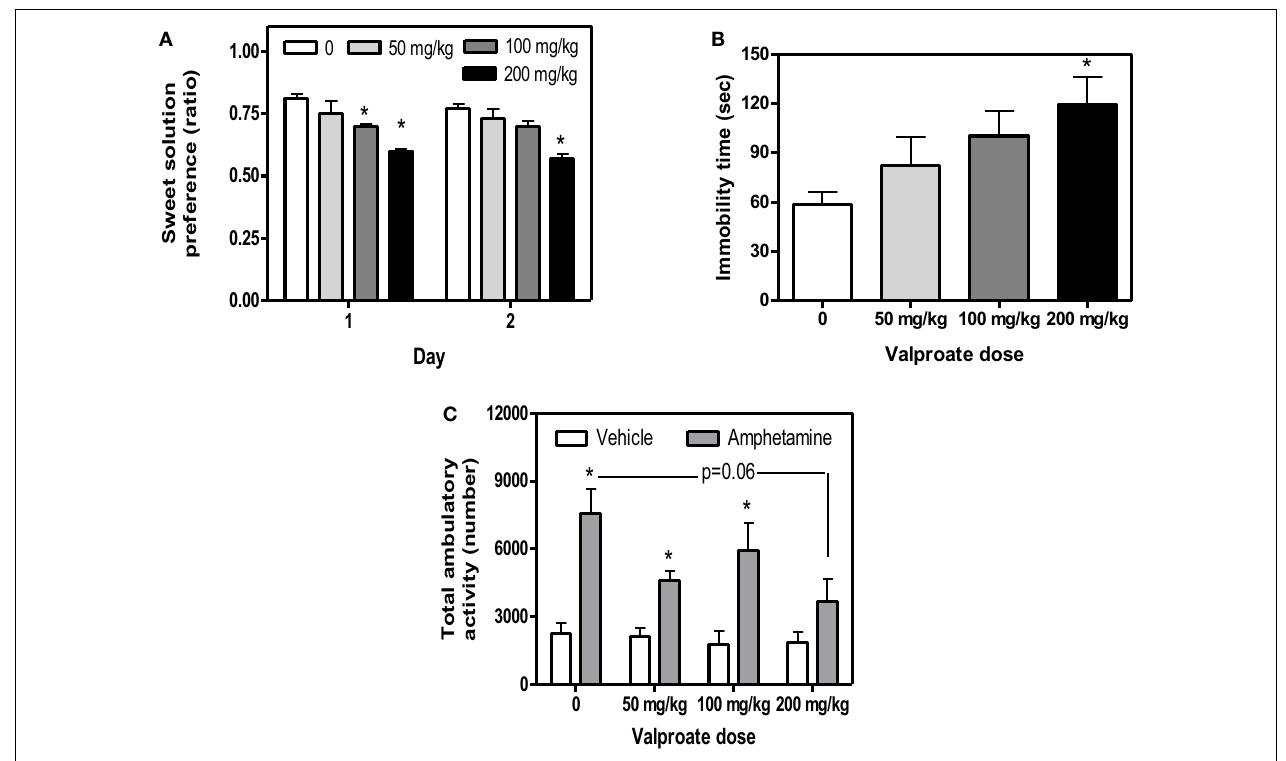
FIGURE 1 | Mean and standard error of (A) saccharin preference ratio on days 1 and 2 of the sweet solution preference test (B) immobility time (s) in the FST of BS mice treated with valproate and (C) total activity of BS mice treated with valproate and amphetamine. *Signifi cantly different from the vehicle group ( p < 0.05). N = 10/group for (A,B) , N = 5/group for